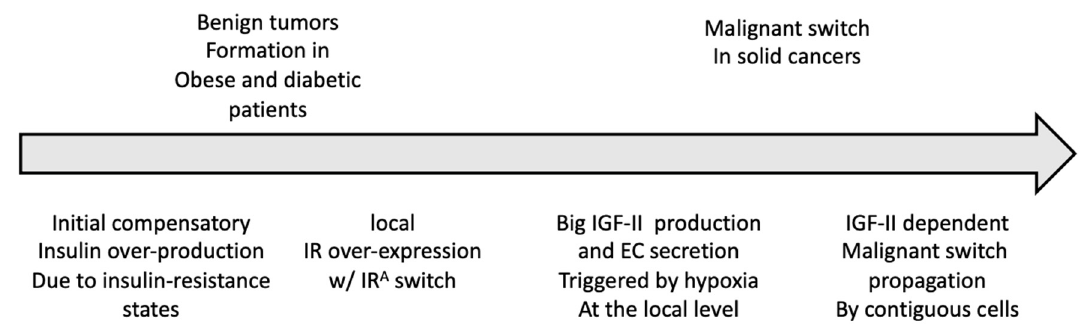
Figure 1. Proposed model for the role of insulin receptor (IR) and insulin growth factor (IGF)-II splicing variants in solid tumor progression from insulin-resistant / hyperinsulinemic states to overt malignancy. Table 1. Alternatively spliced and gene paralogs involved in IR signaling.